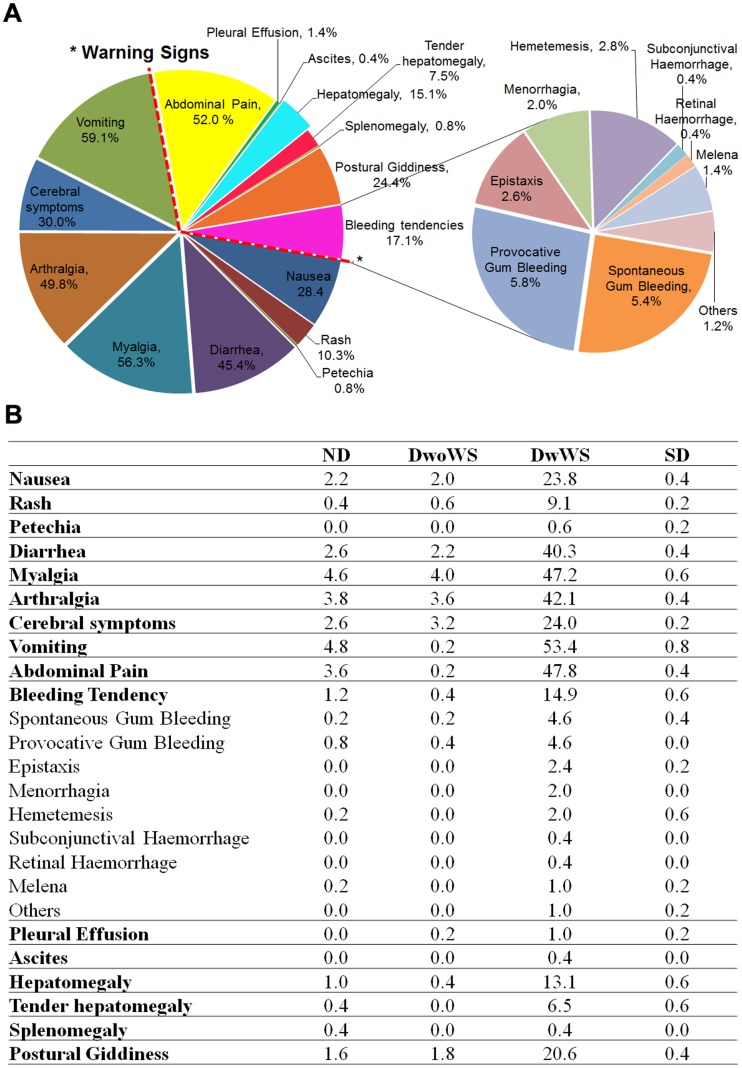
Clinical symptoms of the study population.*indicates the symptoms/manifestations considered as warning signs by the WHO 2009 dengue classification. Detailed clinical symptoms (in percentages) by dengue classification are given in the table.